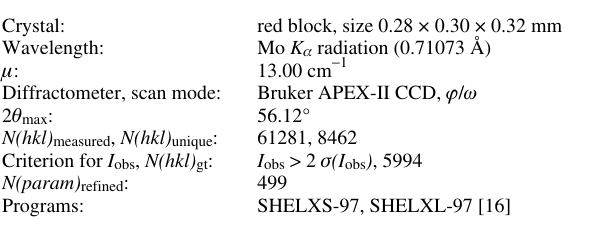
Table 1. Data collection and